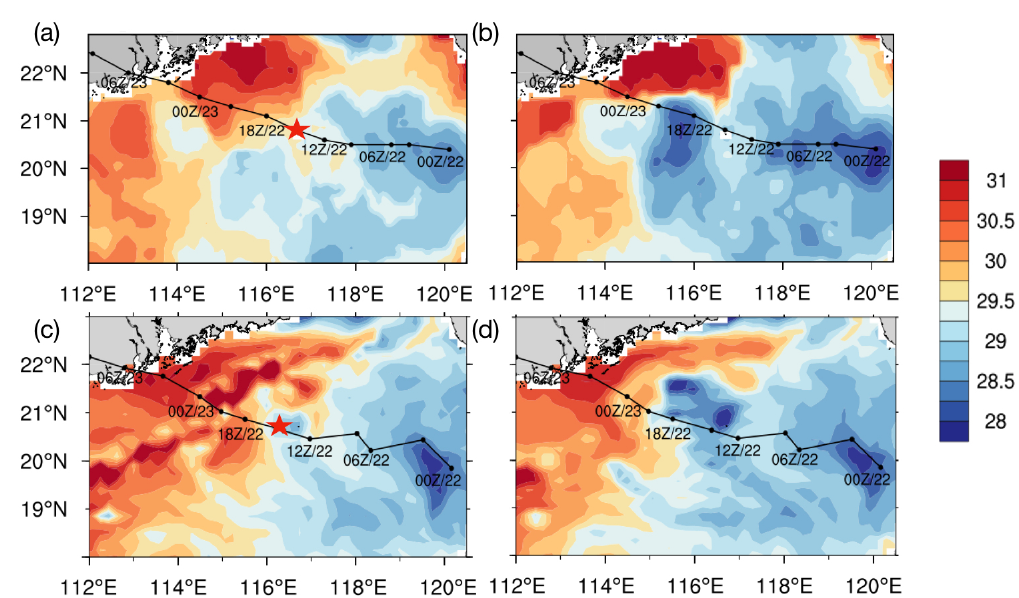
Figure 3. The comparison between the OI_SST and the simulated results ( ◦ C). Panel ( a ) is MV_IR_SST at 1200 UTC on 22 August and panel ( b ) is MV_IR_SST at 1200 UTC on 23 August, on which is the observed best track. Panels ( c , d ) are ROMS output SST at the same time as in panels ( a , b ), overlaying the CPL simulated track. The numbers by two trajectories indicate the location of the TC center at the specific time. The red star indicates the storm center simultaneously with the SST